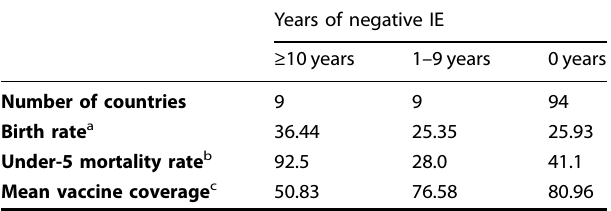
Table 3. Median birth rate, under-5 mortality rate, and mean vaccine coverage for countries strati fi ed by the number of years for which the model predicted negative indirect effects.